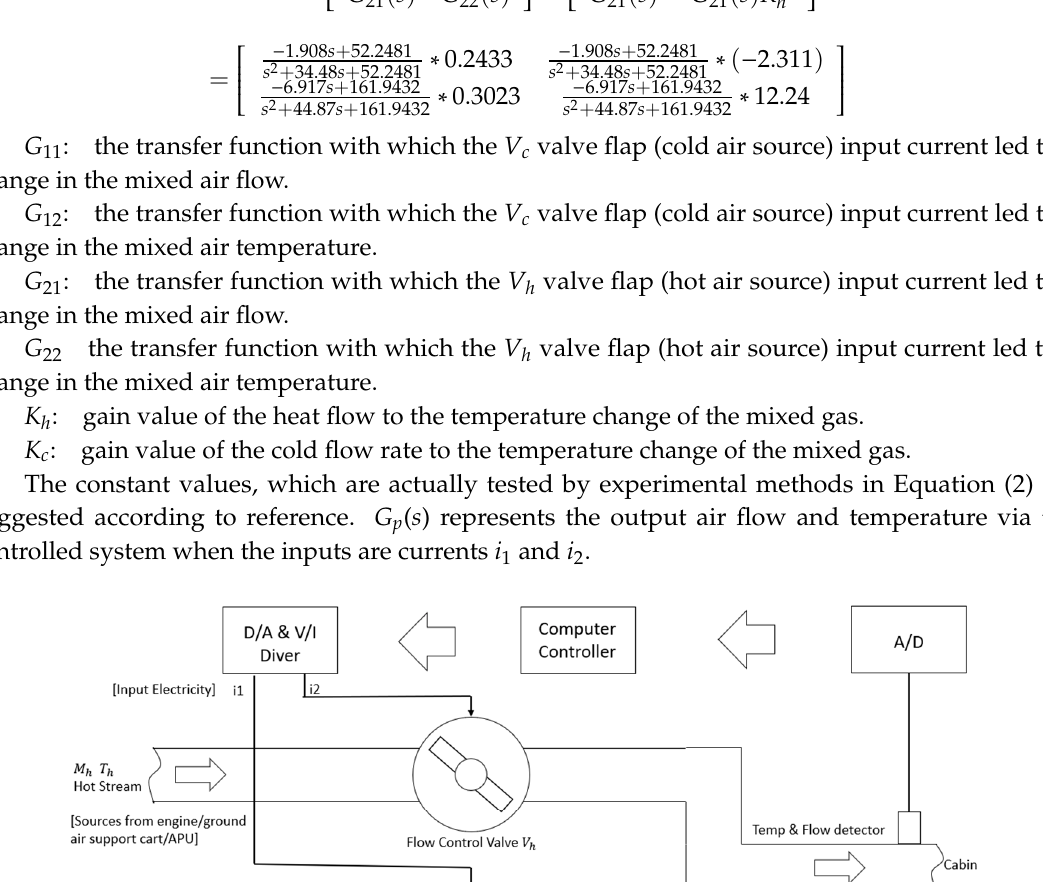
Figure 2. Flowchart modeling the environmental control system. 2.2. PID Control The PID controller design is used in this study to control the air temperature and flow. A PID control consists of three units: proportional ( K p ), integral ( K i ), and derivative ( K d ). The so-called control tunes the gain values of these three units. u ( t ) is defined as the output function of the controller at time t , and then a PID controller can be expressed as the following mathematical formula [2]: